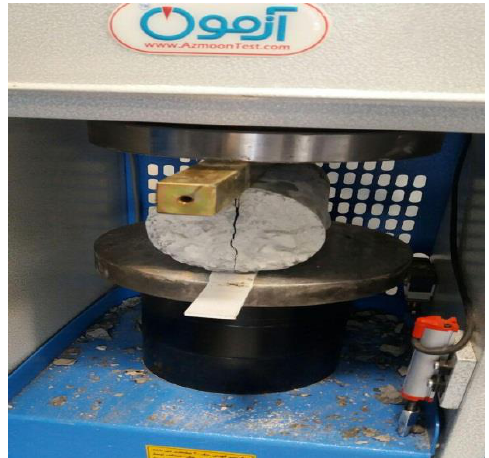
Figure 8. Performing compressive strength test of concrete . Table 14. Tensile strength of